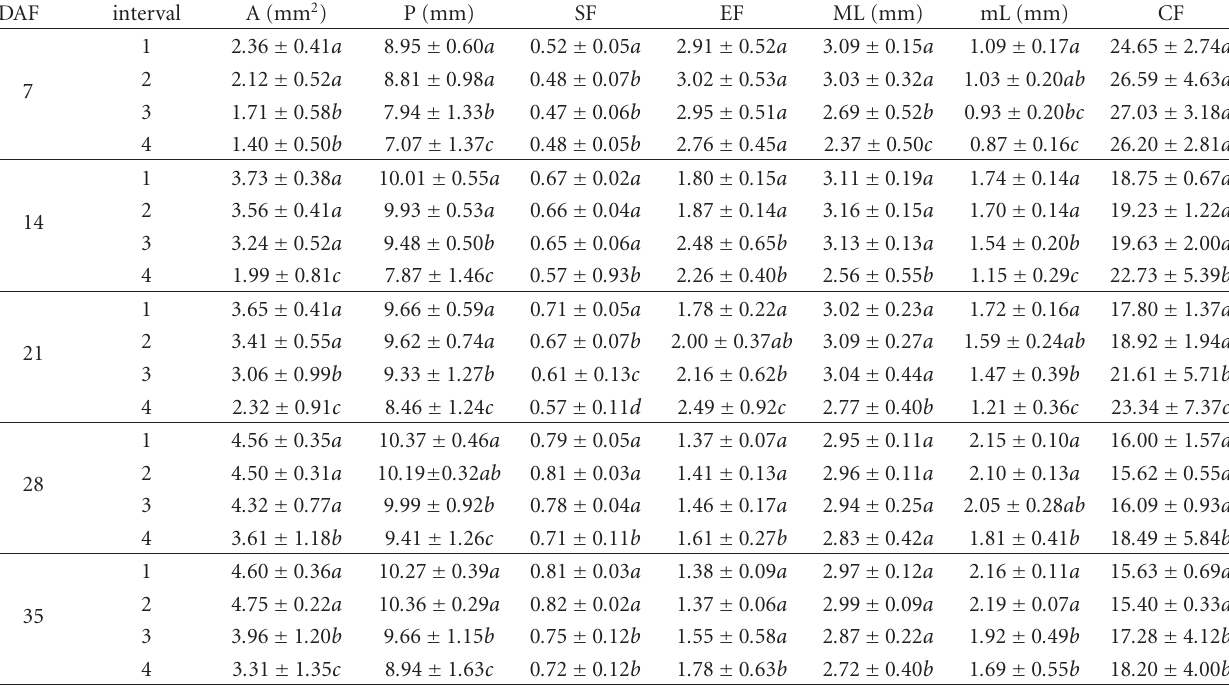
Table 1: Comparison of dimensional morphometric and form descriptors by interval in transversal cut sections of rice grain Morelos A-98. DAF